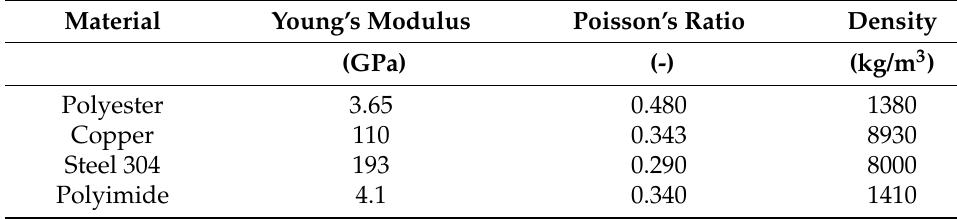
Table A2. Packaging material properties.